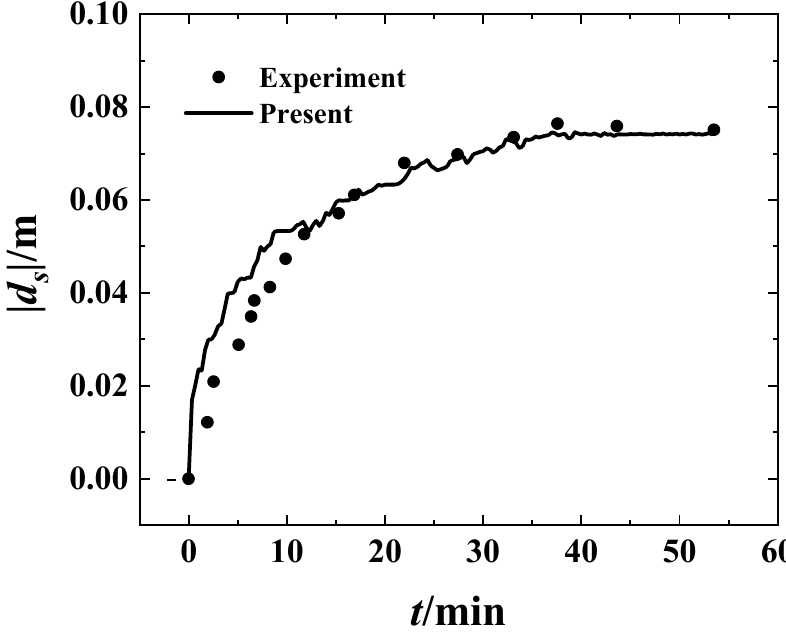
Figure 4. Time evolution of maximum scour depth around the cylinder.